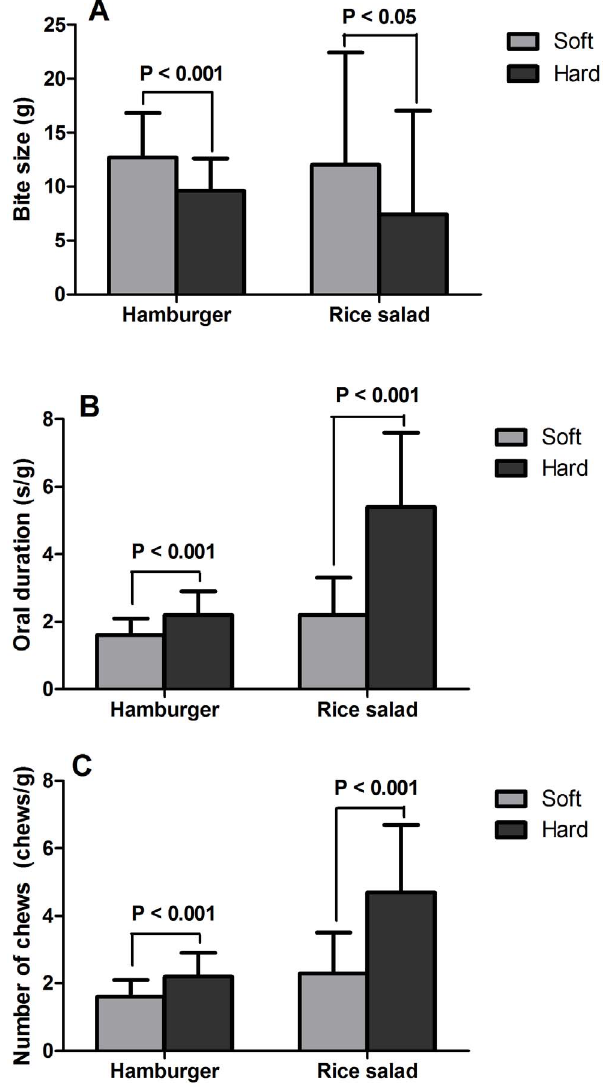
Figure 3. Differences in oral processing characteristics of soft and hard foods, n=36 (means and SD); bite size (g) (A), oral residence duration (s/g) (B) and chews (no of chews/g) (C).